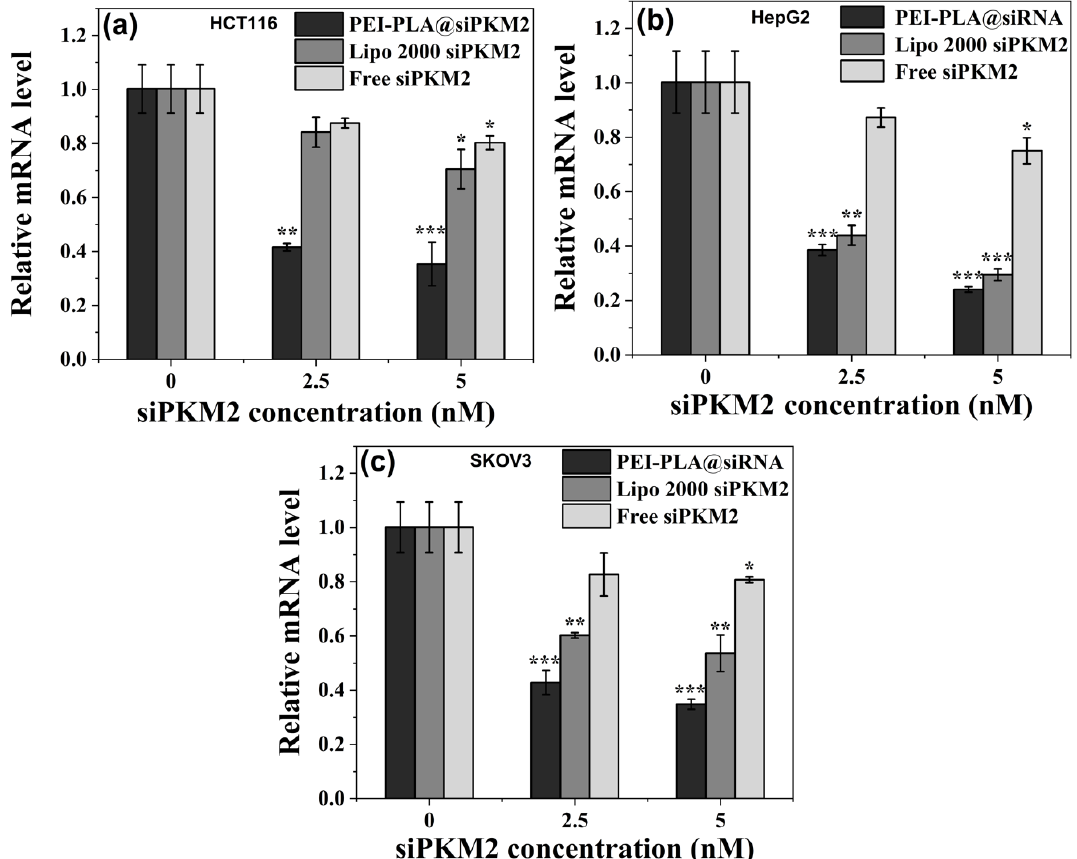
Figure 7. Real-time PCR analysis of PKM2 mRNA levels in HCT116 ( a ), HepG2 ( b ), and SKOV3 ( c ) cells. Cells were treated with PEI-PLA@siPKM2 polyplex, Lipo 2000 and free siPKM2 for 144 h, siRNA transfection was repeated at 48 and 96 h. * indicates P < 0.05, ** indicates P < 0.01, and *** indicates P < 0.001, relative to the control cells.